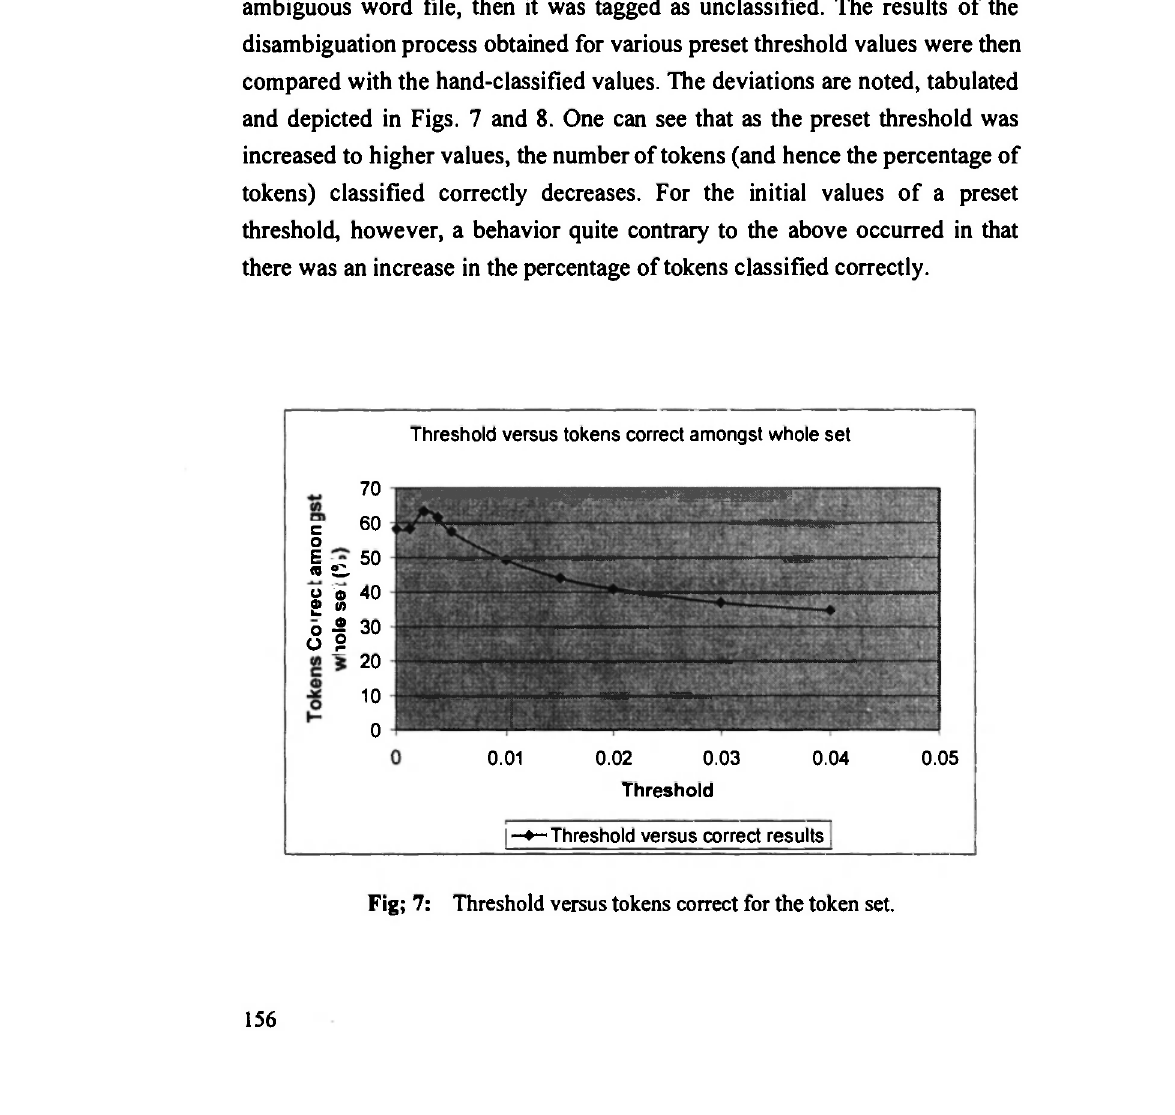
Fig; 7: Threshold versus tokens correct for the token